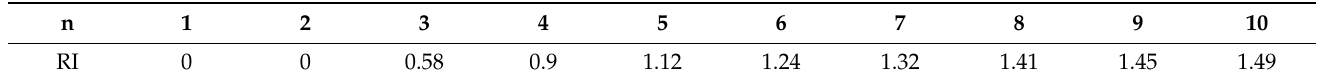
Table 4. Random indices function of the number of elements compared